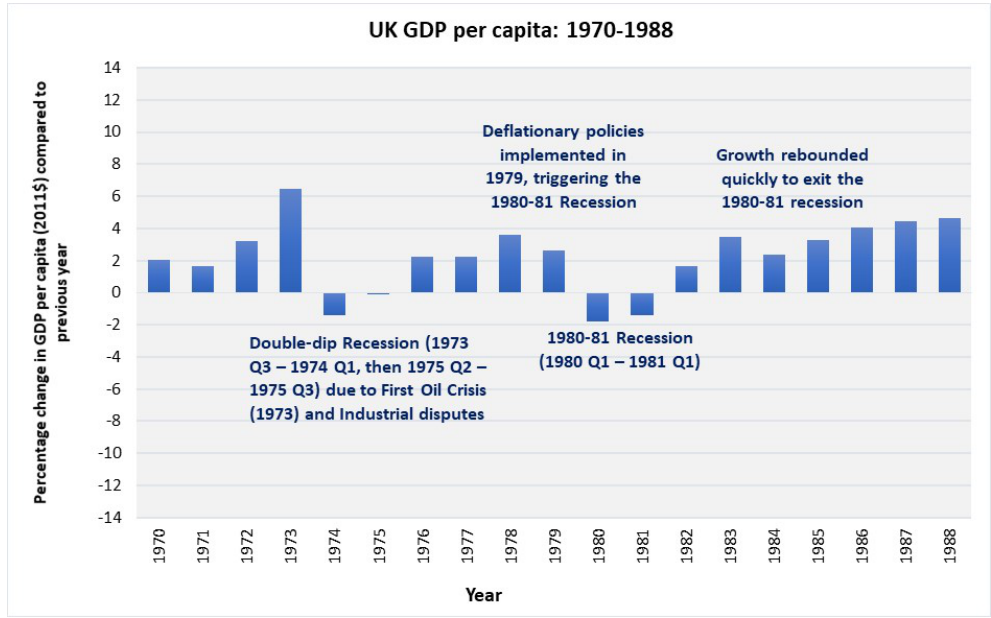
Figure 6. Annual growth rates as the UK navigated the rocky 1970s and the Recession and subsequent recovery of the early 1980s (see Note